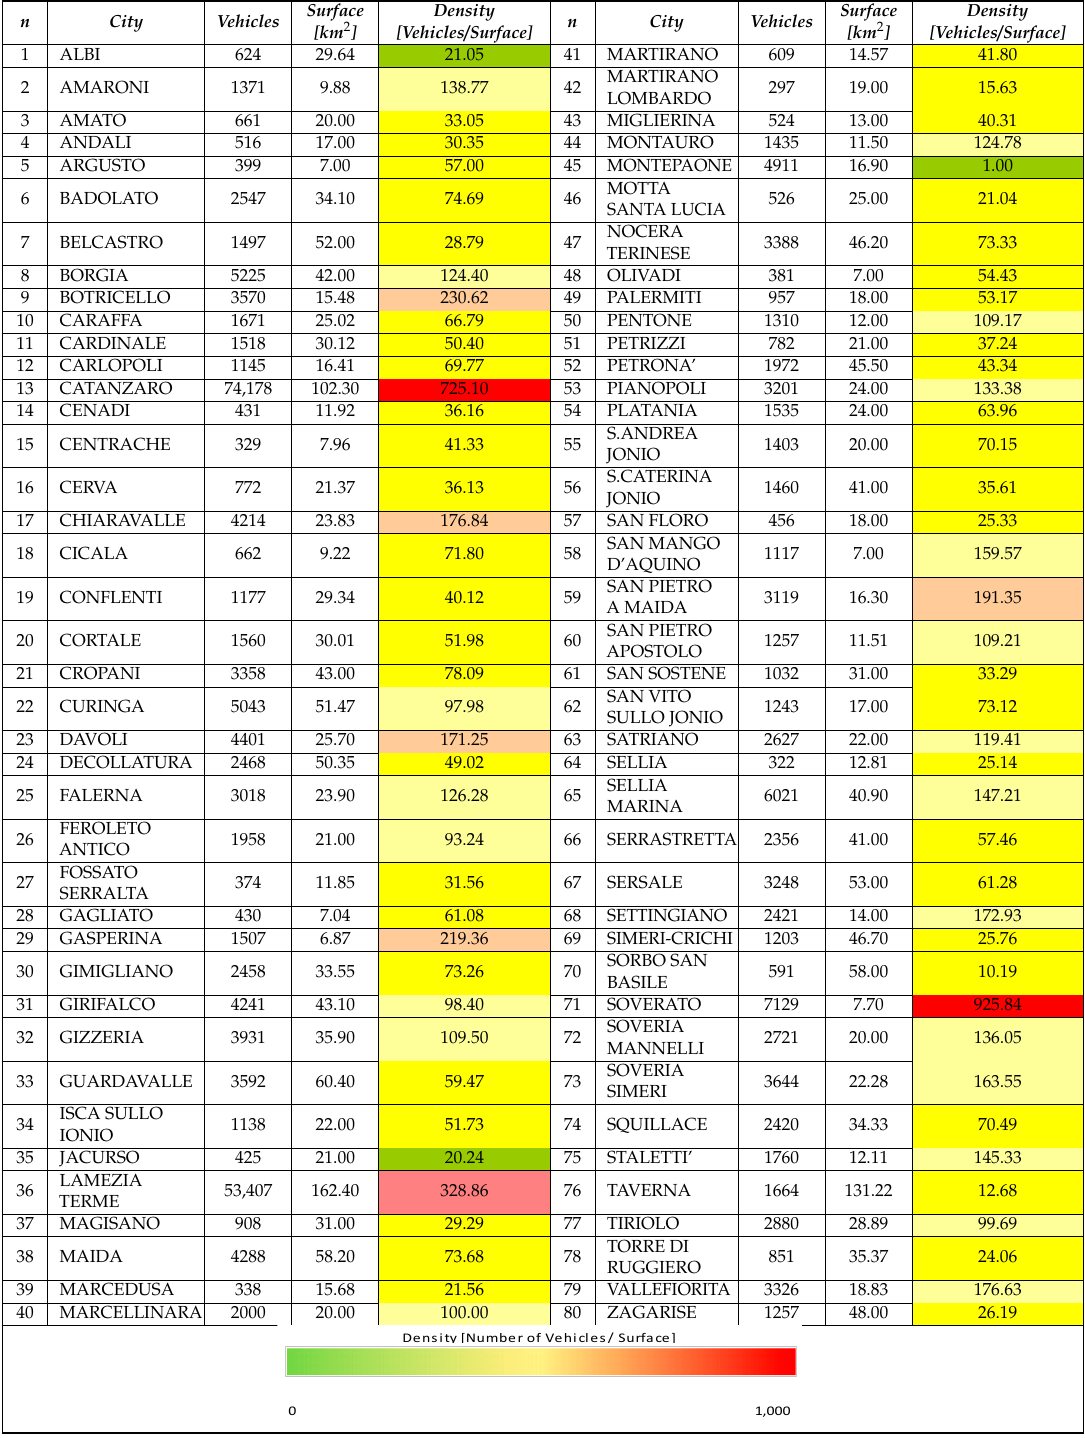
Table 2. Area, number of vehicles, and density of vehicles (number of vehicle / area), in 2015 for cities in the province of Catanzaro.